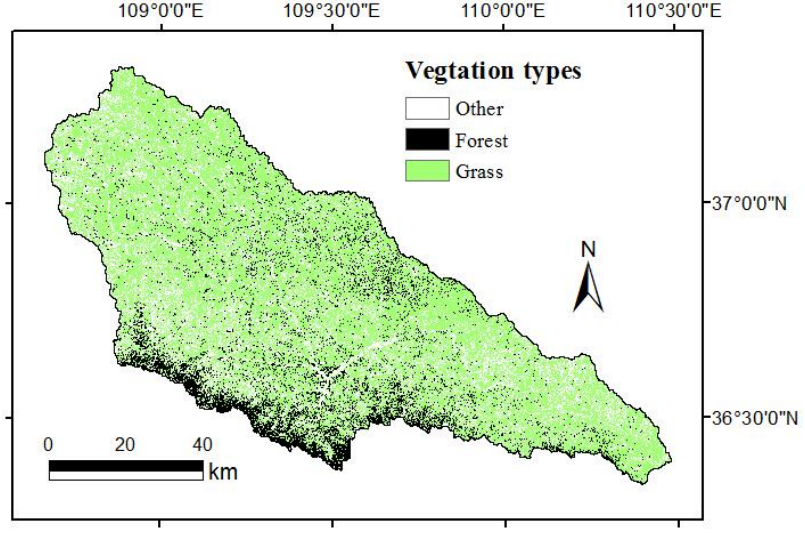
Figure 2. Distribution of actual vegetation in the Yanhe River catchment.